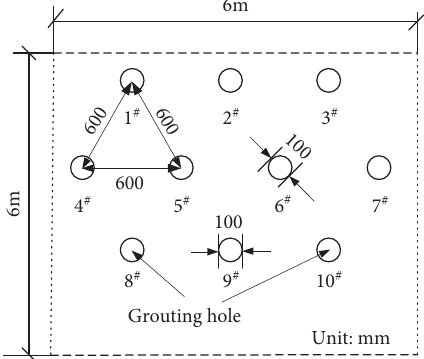
Figure 5: Grouting hole arrangement